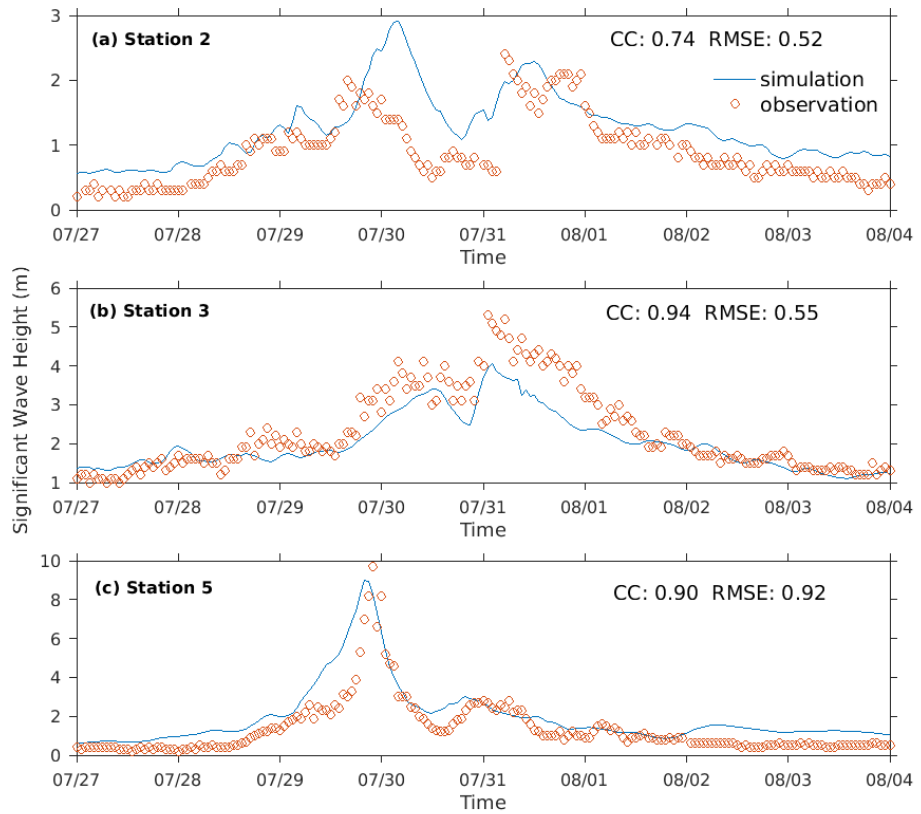
Figure 6. Comparison of significant wave height between model and observed data for ( a ) Station 2, ( b ) Station 3, and ( c ) Station 5. CC denotes correlation coefficient, RMSE is the root mean square error. The positions of stations are shown in Figure 2c.